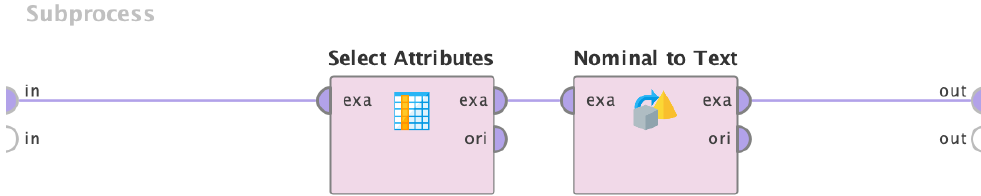
Figure 3. The input port (in) contained the entire example set to be processed in the Select Attributes and Nominal to Text operators. Converted examples were sent to the output port for prepro- cessing.